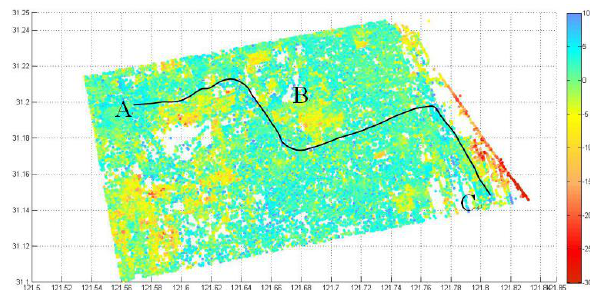
Figure 3. Deformation rate of the coherent points in LOS In Figure 3, the black line stand for the extension of Line 2. A stand for Longyang Road Station, B stand for Pudong Airport, and C stand for Chuansha Town. It can be seen from Figure 3 that the distribution of coherent targets is relatively